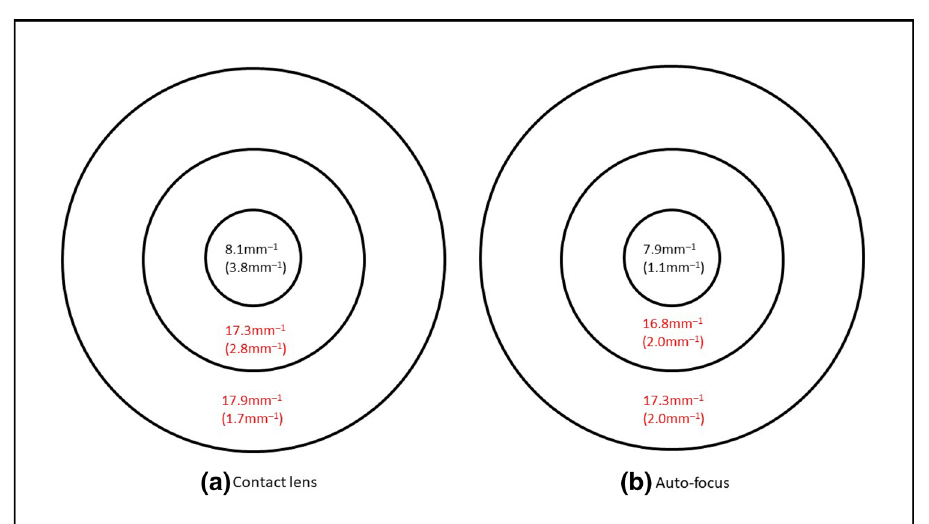
Figure 2. Vessel length density of 74 eyes when corrected with ( a ) contact lens and ( b ) the auto-focus system. Results are expressed as median (interquartile range) using the ETDRS central circle, inner and outer rings of the 6 mm grid. Significant difference between the two correction methods is marked in